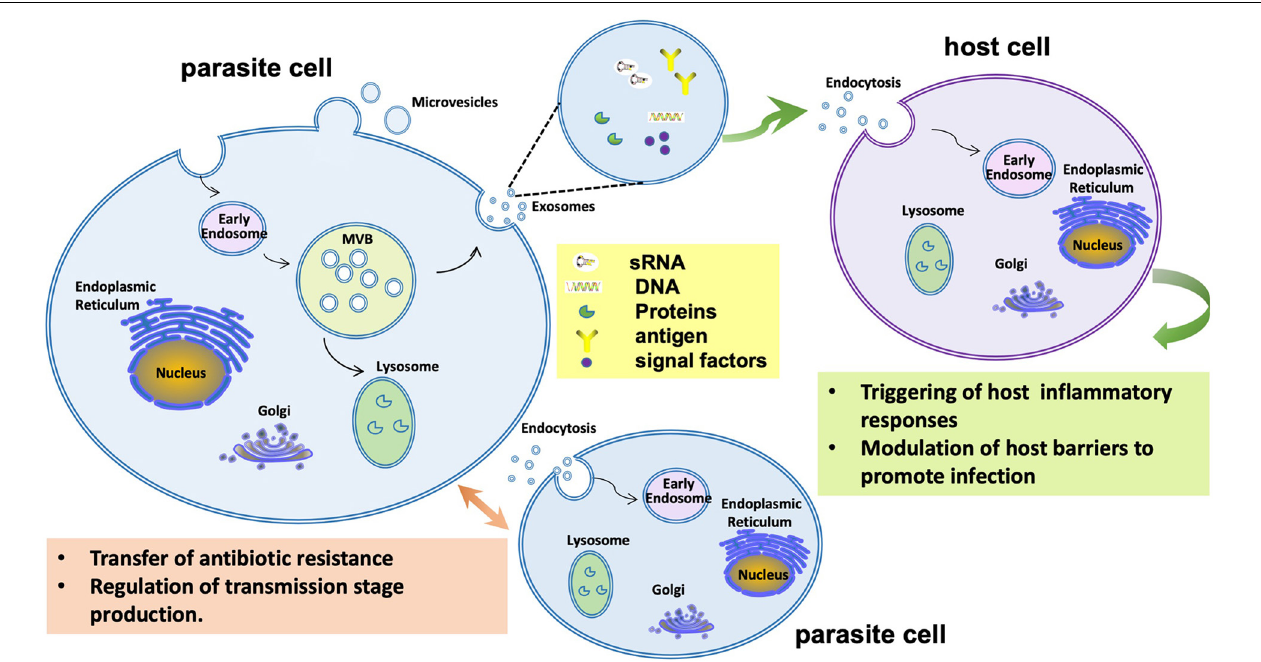
FIGURE 5 | Extracellular vesicle functions during infection by the malaria parasite Plasmodium falciparum . During infection P. falciparum EVs may trigger host inflammatory responses or manipulate gene expression to reduce host barriers to infection. P. falciparum EVs may also mediate communication among parasite cells to regulate transmission stage production or even transfer antibiotic